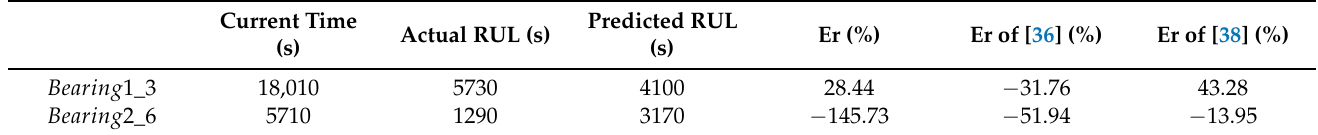
Table 3. RUL prediction results compared with other